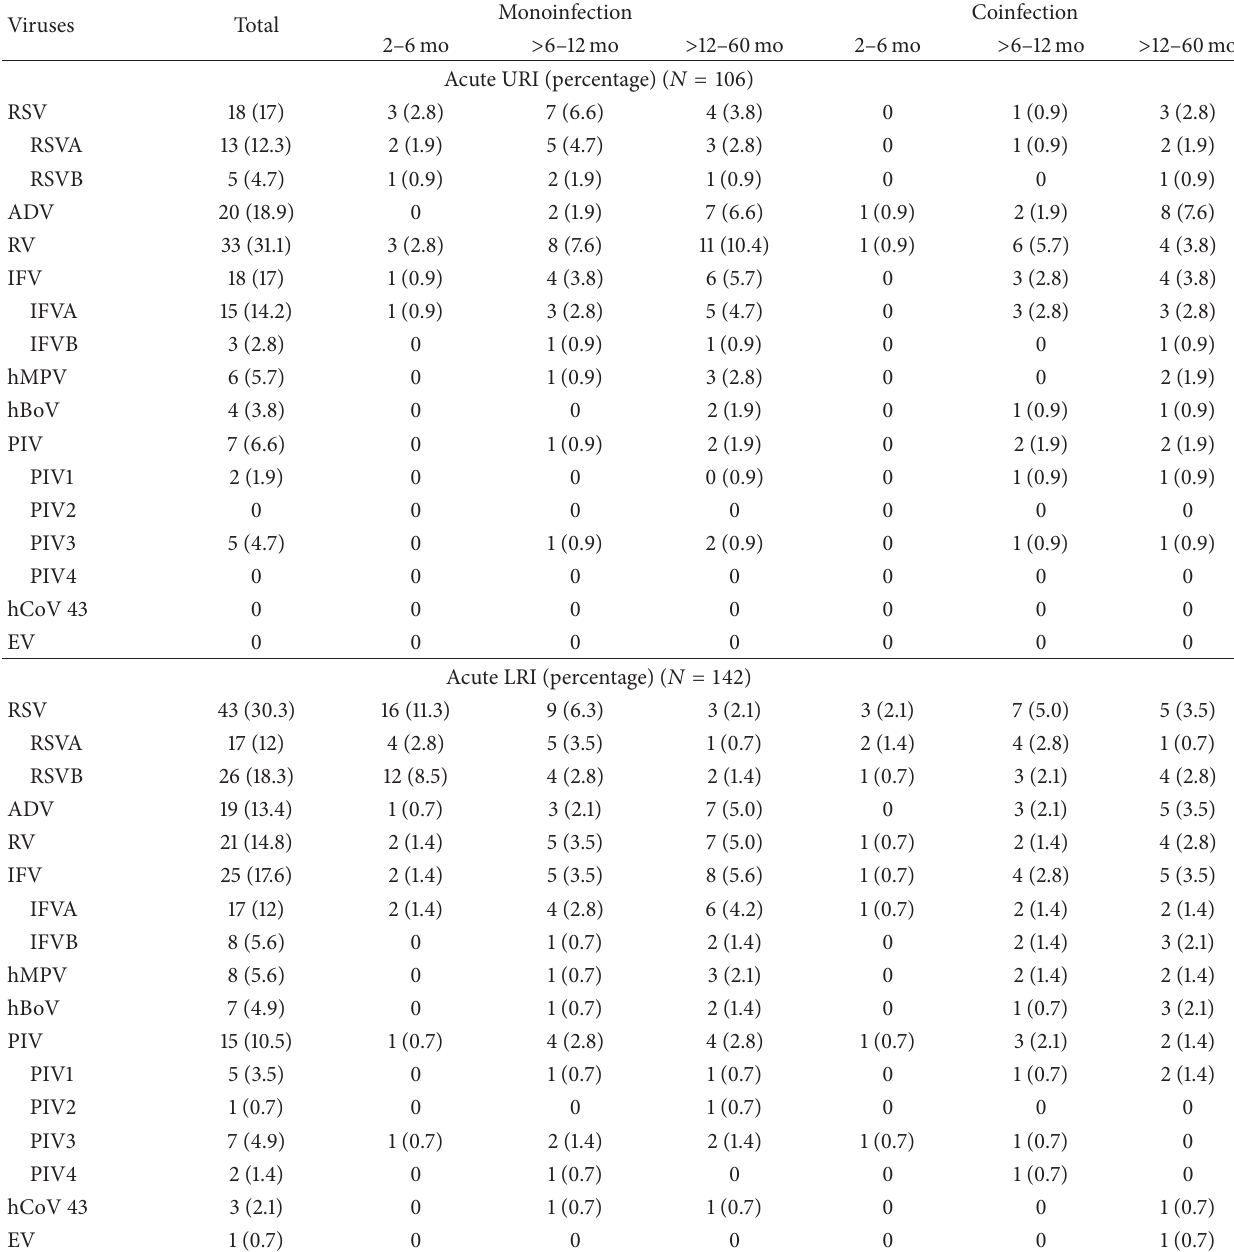
Table 1: Isolation of viruses (monoinfection versus coinfection) in children with ARIs.